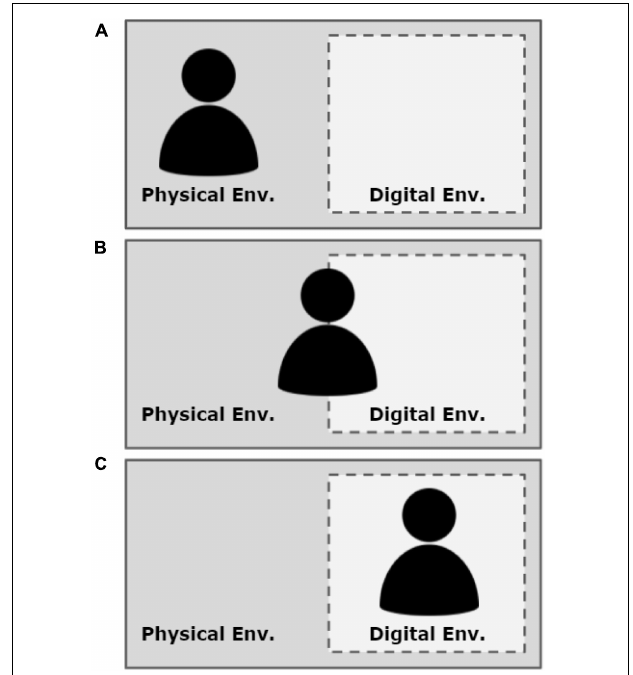
FIGURE 1 | (A–C) Illustrating Binta’s states of embeddedness and nested physical (obligate) and digital (facultative) environmental systems. The solid bounding box of the physical (obligate) environment aims to illustrate its relative permanence/impermeability as compared to the dashed bounding box of the digital (facultative)